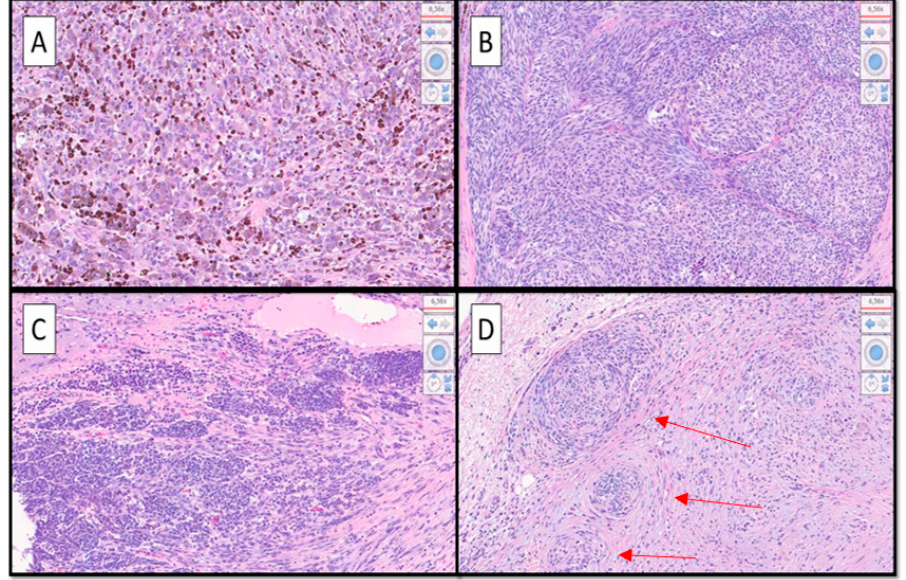
Figure 2. The histopathological evaluation showed a nodular lesion overlaying the auricular cartilage and extending to ulcerate the overlying epidermis (Hematoxylin-Eosin, Original Magnification 2× ( A ) and 4× ( B )). A diagnosis of polymorphic malignant melanoma (PMM) was made, with a vertical growth phase of tumorigenic type, up to 4.5 mm thick according to Breslow, with a number of mitoses / mmq> 1, as well as lymphovascular invasion, neurotropism, and microsatellitosis, staged according to the AJCC 8 ′ Edition as pT4b N1c. The sample was then subjected to molecular biology tests to search for mutations in exons 11 and 15 of the BRAF gene and in exons 2, 3, and 4 of the NRAS gene by RealTime PCR. This revealed a mutation in codon V600 of exon 15 of the BRAF gene (V600E / E2 / D). No mutations were detected in exons 2, 3, and 4 of the NRAS gene.